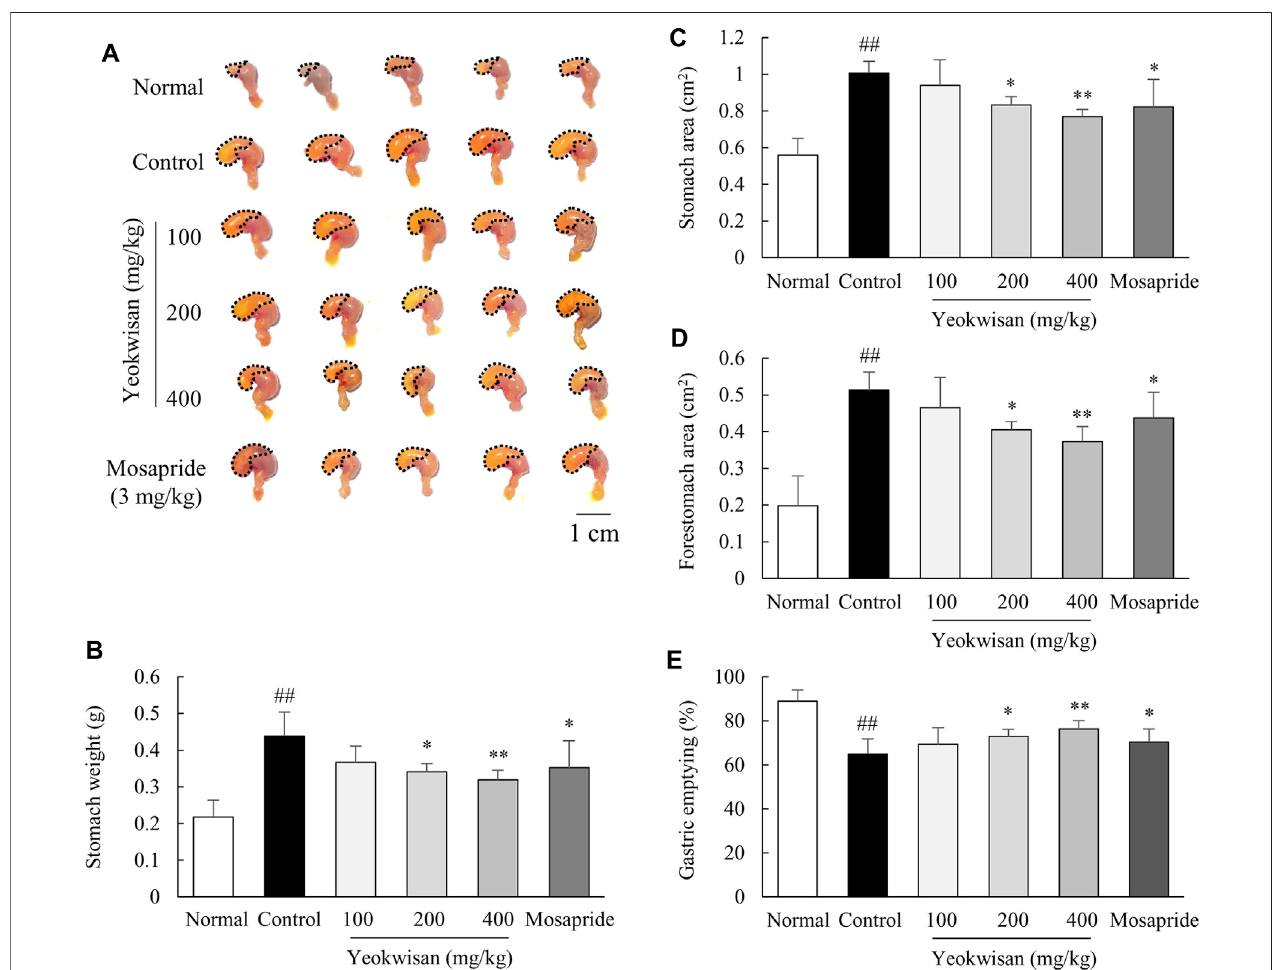
FIGURE 2 | Effects of Yeokwisan on gastric emptying. For 5 days, the mice (n (cid:2) 6/group) were orally administered Yeokwisan (100, 200 and 400 mg/kg) or mosapride (3 mg/kg) and then intraperitoneally injected with loperamide (10 mg/kg). After the administration of phenol red, visual observation (A) , stomach weight (B) , stomach area (C) , forestomach area (D) and gastric emptying (E) were assessed. The data are presented as the mean ± SEM. ## p < 0.01 compared with the normal group; * p < 0.05, ** p < 0.01 compared with the control group.